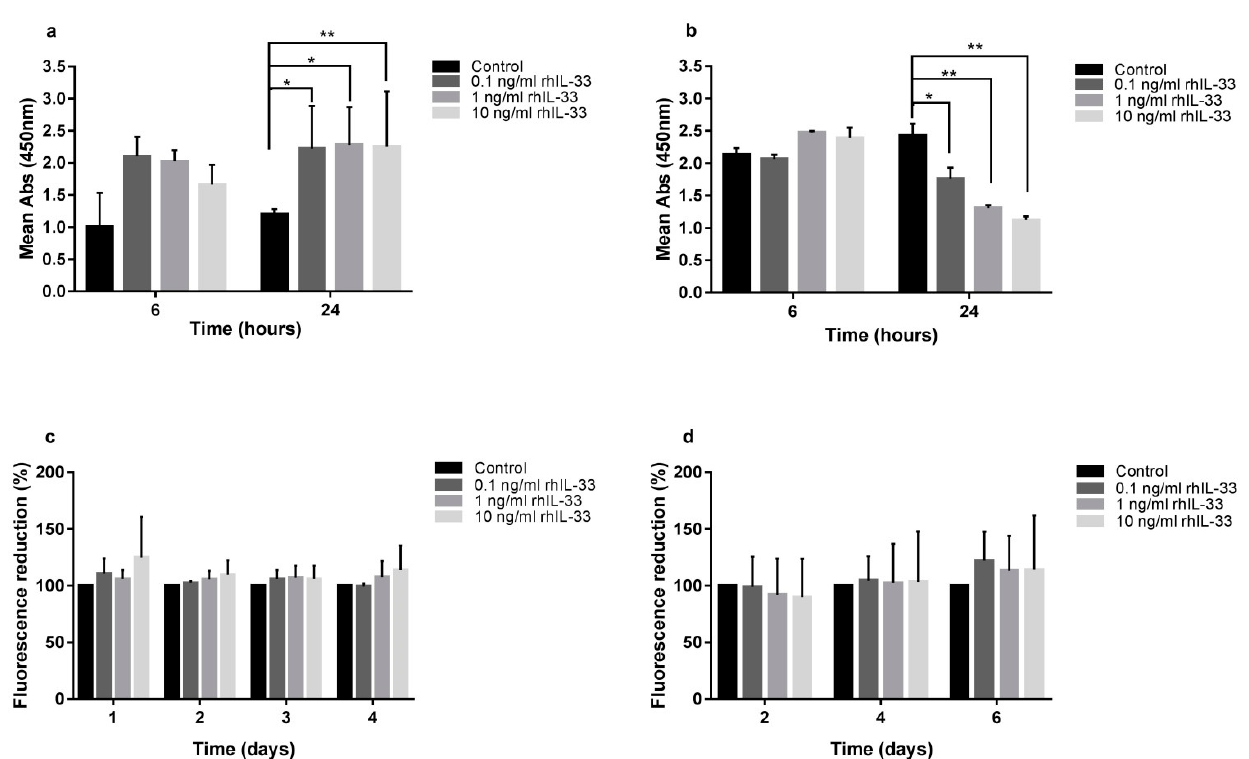
Figure 2. Exogenous administration of rhIL-33 induced the activation of a proliferative metabolic pathway in normal gastric epithelial cells, while the same challenge on neoplastic cells did not activate proliferation. Colorimetric XTT assay shows the proliferative effect on GES-1 ( a ) and the antiproliferative effect on AGS ( b ) after 24 h treatment; fluorescent CFSE assay ( b – d ) did not show any statically significant variation in proliferation. Data are shown as mean ± SD. * p < 0.05; ** p < 0.01.